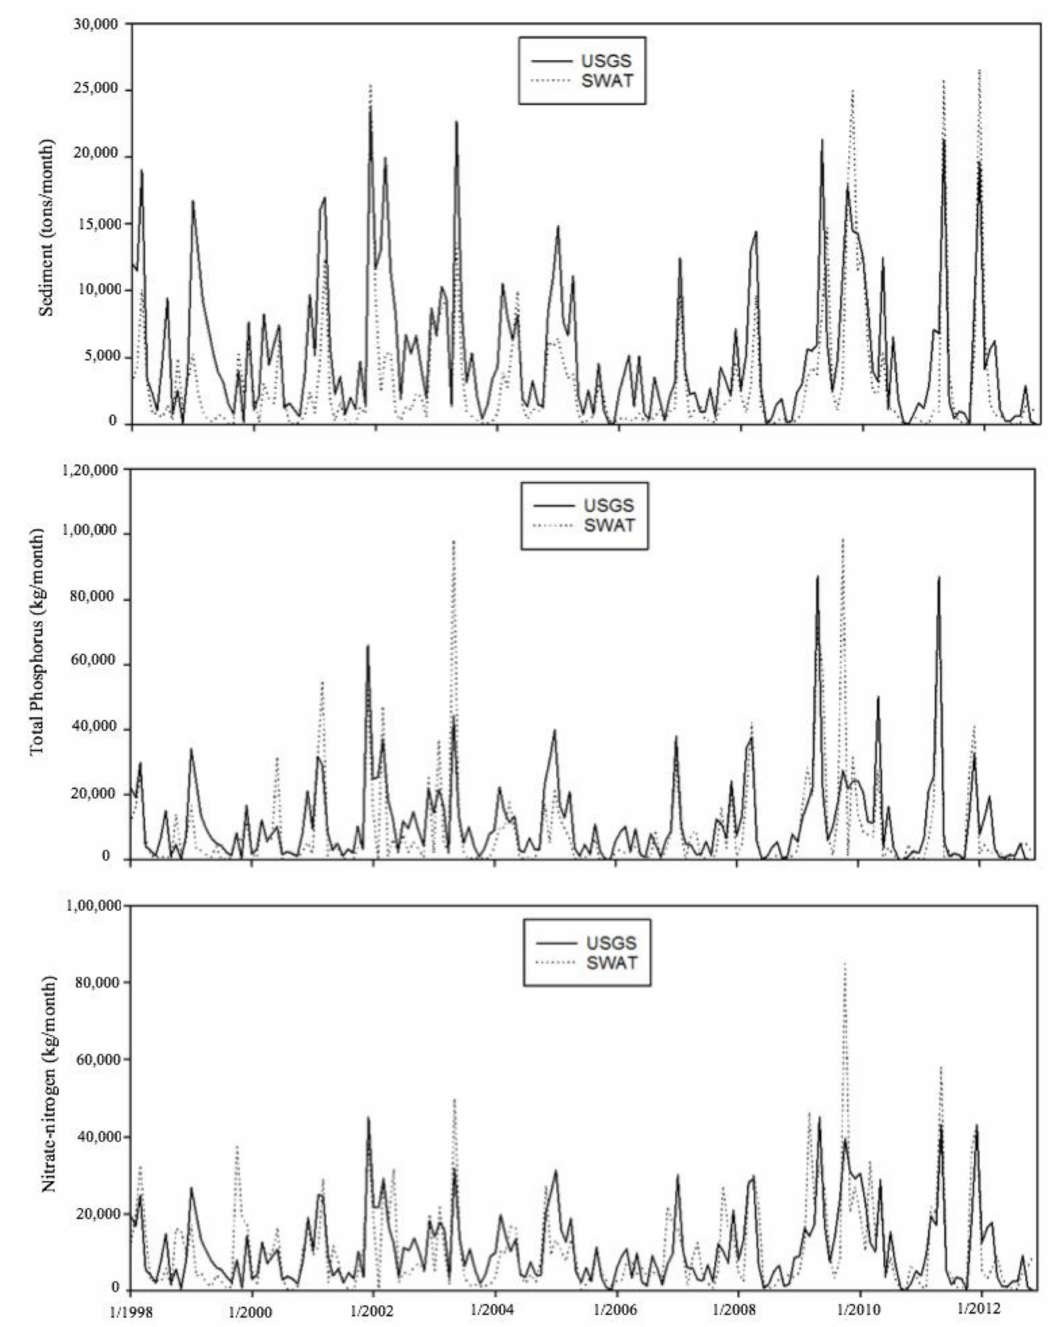
Figure 5. Graphical comparison of the USGS (estimated using the Load Estimator, or LOADEST) and SWAT (simulated) water quality data at the Colt